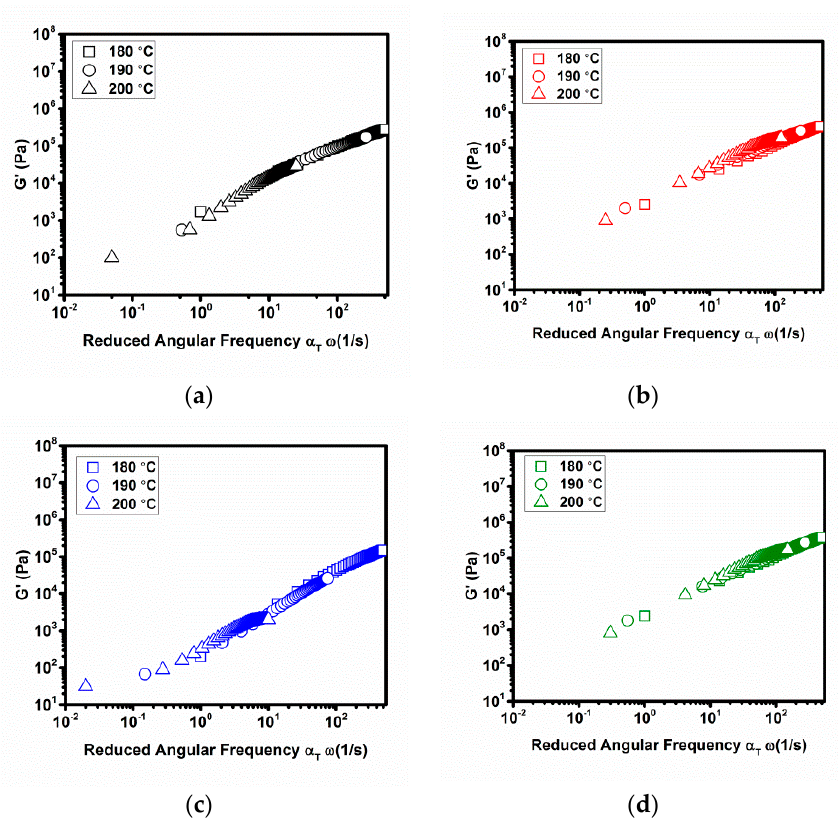
Figure 11. Master curve obtained from time–temperature superposition of ( a ) TPU ‐ PTC ‐ PDO, ( b ) TPU ‐ PHC ‐ PDO, ( c ) TPU ‐ PTC ‐ BDO, and ( d ) TPU ‐ PHC ‐ BDO.